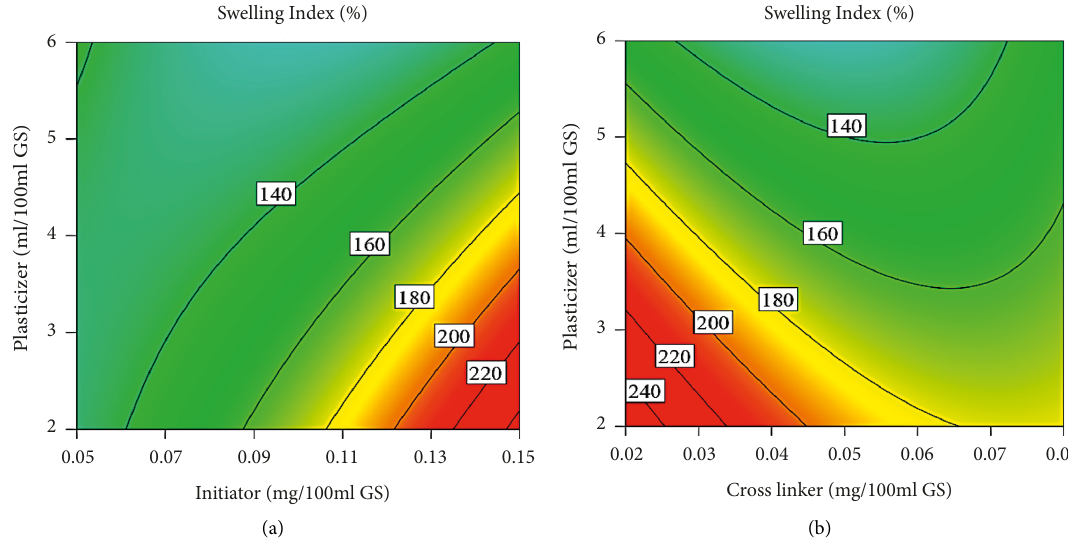
Figure 4: (a) Combined effects of initiator and plasticizer concentration on swelling index at the optimum value of crosslinker (0.02mg/ 100mL GS). (b) Combined effects of crosslinker and plasticizer concentration on swelling index at the optimum value of initiator (0.15 mg/ 100mL GS).